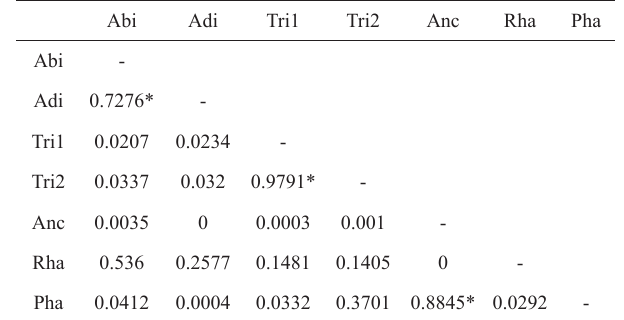
Table 2. Pianka overlap index for trophic niche. calculated for each pair of fish species from Jumelo stream. Iguaçu National Park. Paraná. Brazil. An asterisk indicates high overlap values (<0.6). Abi= Astyanax bifasciatus; Adi= Astyanax dissimilis ; Tri1= Trichomycterus sp.1; Tri2= Trichomycterus sp.2; Anc= Ancistrus mullerae; Rha= Rhamdia branneri; Pha= Phalloceros harpagos.